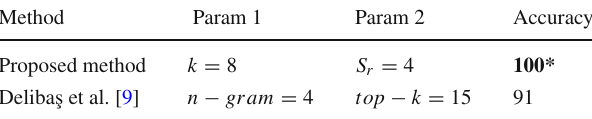
Table 8 DNA similarity identification accuracy comparison for 16S Ribosomal DNA dataset